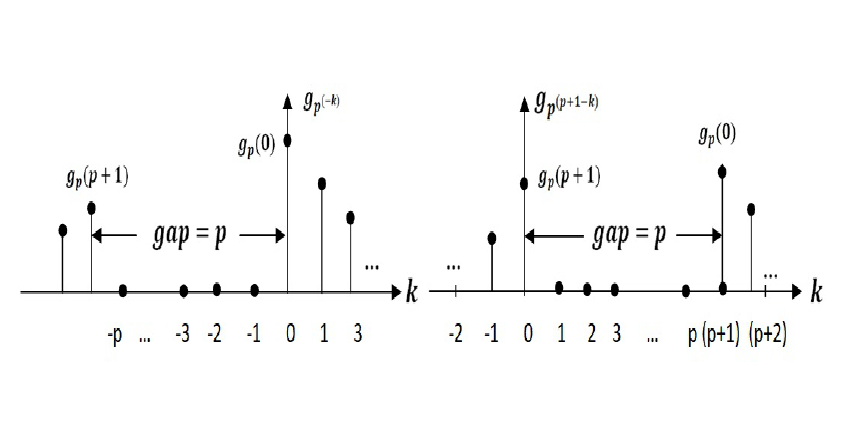
( k ) and g ( p + 1 − k p p